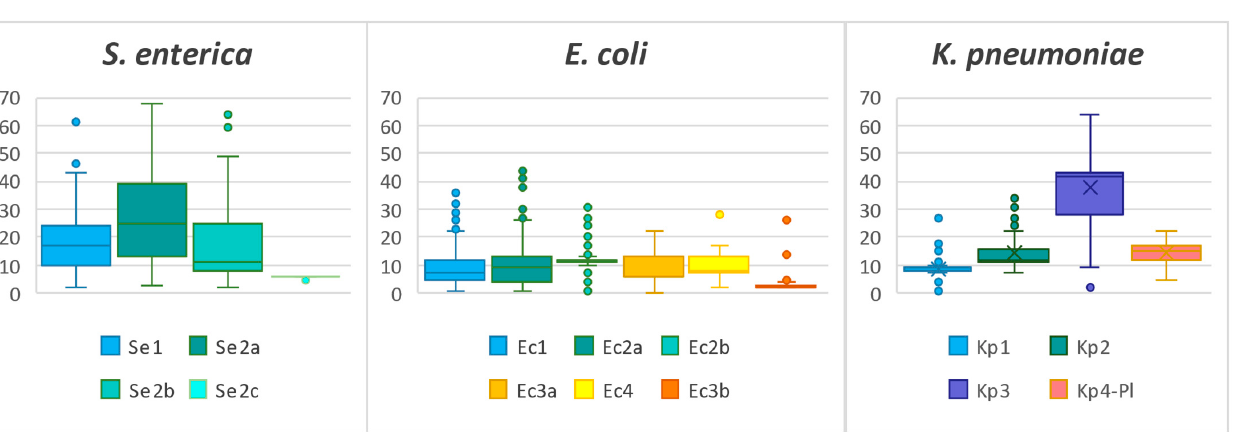
not part of the main loci.